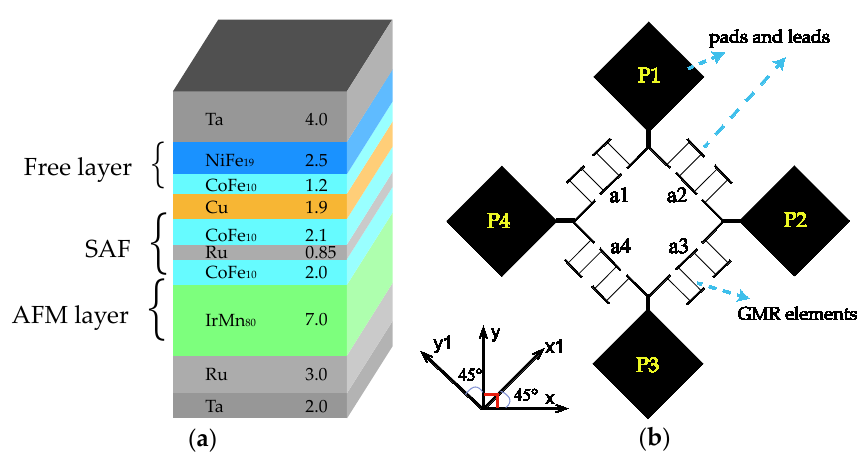
Figure 2. ( a ) Structure of GMR stack with SAF CoFe 10 /Ru/CoFe 10 . ( b ) Layout of Wheatstone bridge sensor. P1–P4 are four electrodes of the bridge used for electrical measurements. Each bridge arm (a1–a4) consists of four GMR stripes with dimensions of 3 × 225 μm connected in series. The meander connection of four stripes is used to obtain the resistance as designed in the bridge.